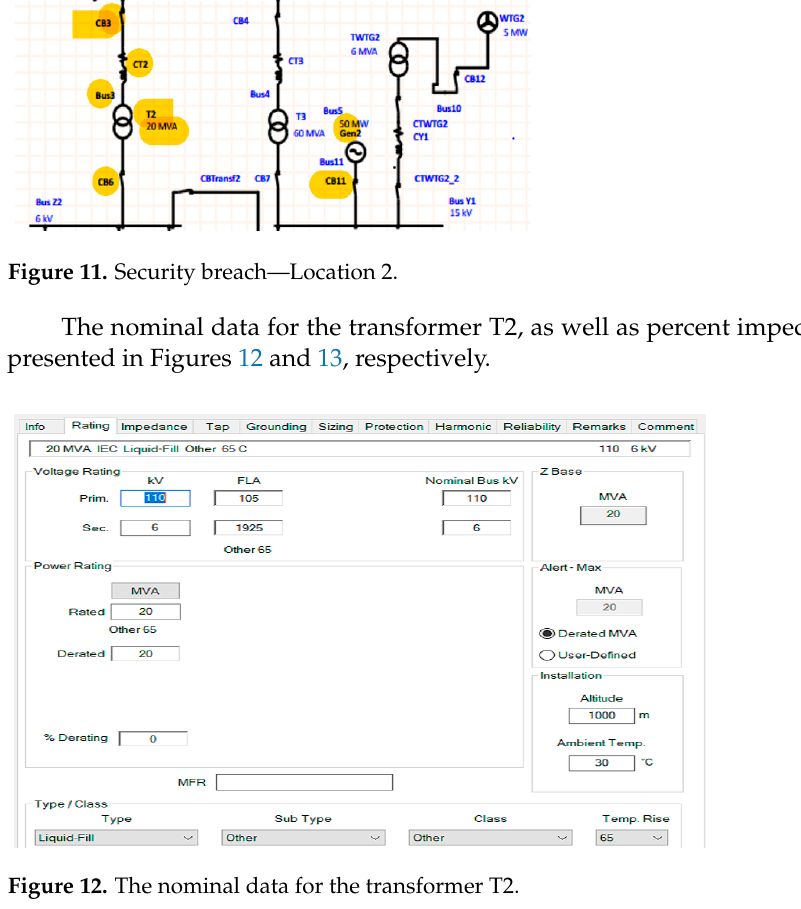
Figure 12. The nominal data for the transformer T2.